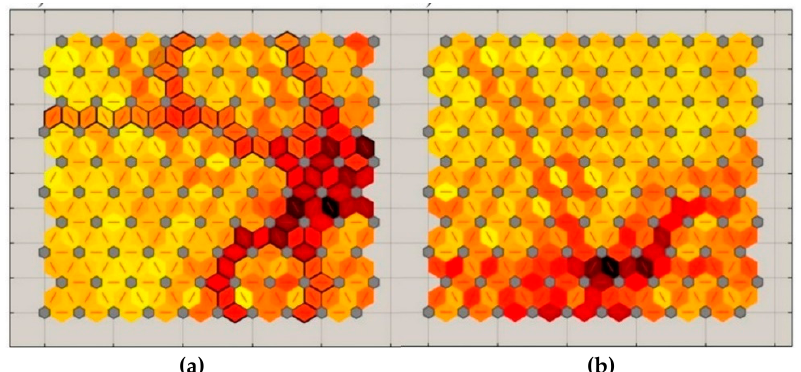
Figure 11. Influence of the number of training epochs to the SOM neighbourhood distances: ( a ) 600 training epochs; ( b ) 200 training epochs.